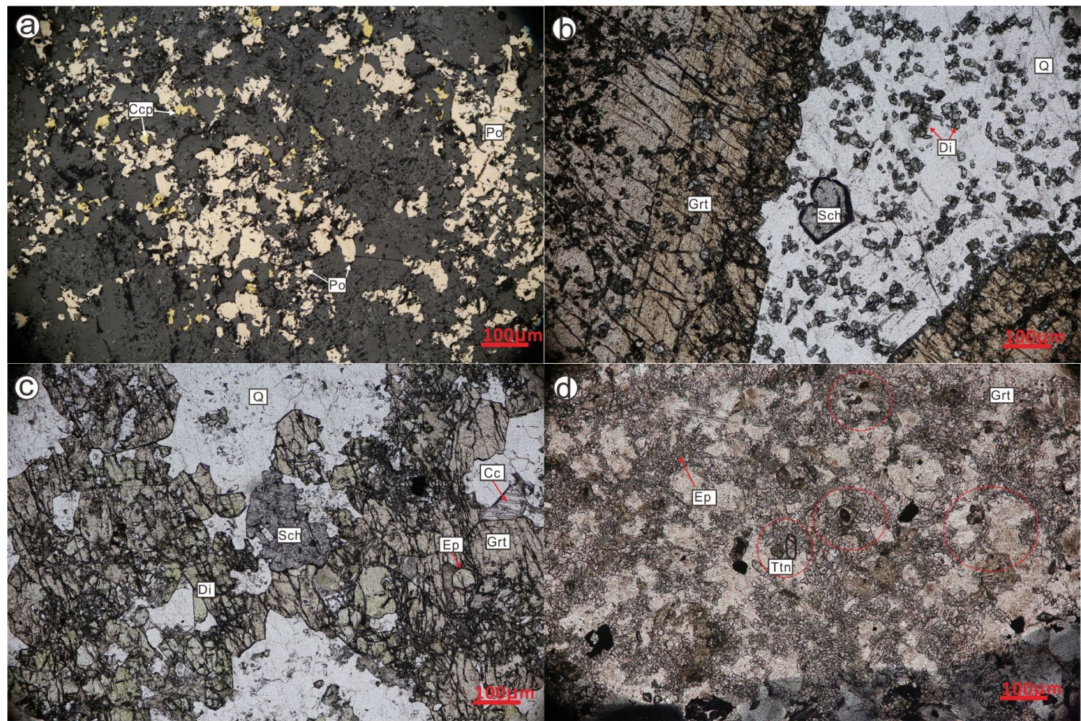
Figure 3. Photomicrographs of skarns from the Zhuxiling W (Mo) deposit. ( a ) Diopside skarn consists of diopside, quartz, and large amounts of pyrrhotite, as well as minor amounts of chalcopyrite and titanite; ( b ) garnet skarn consists of large euhedral garnet crystal, small diopside as inclusions inside quartz and garnet, as well as disseminated scheelite. ( c ) Garnet-diopside skarn where garnet is replaced by epidote, calcite, and scheelite. ( d ) Retrograde skarn with massive epidote, quartz, and disseminated titanite. Abbreviations: Ccp: chalcopyrite; Po: pyrrhotite; Grt: garnet; Sch: scheelite; Di: diopside; Q: quartz; Ep: epidote; Cc: calcite; and Ttn: